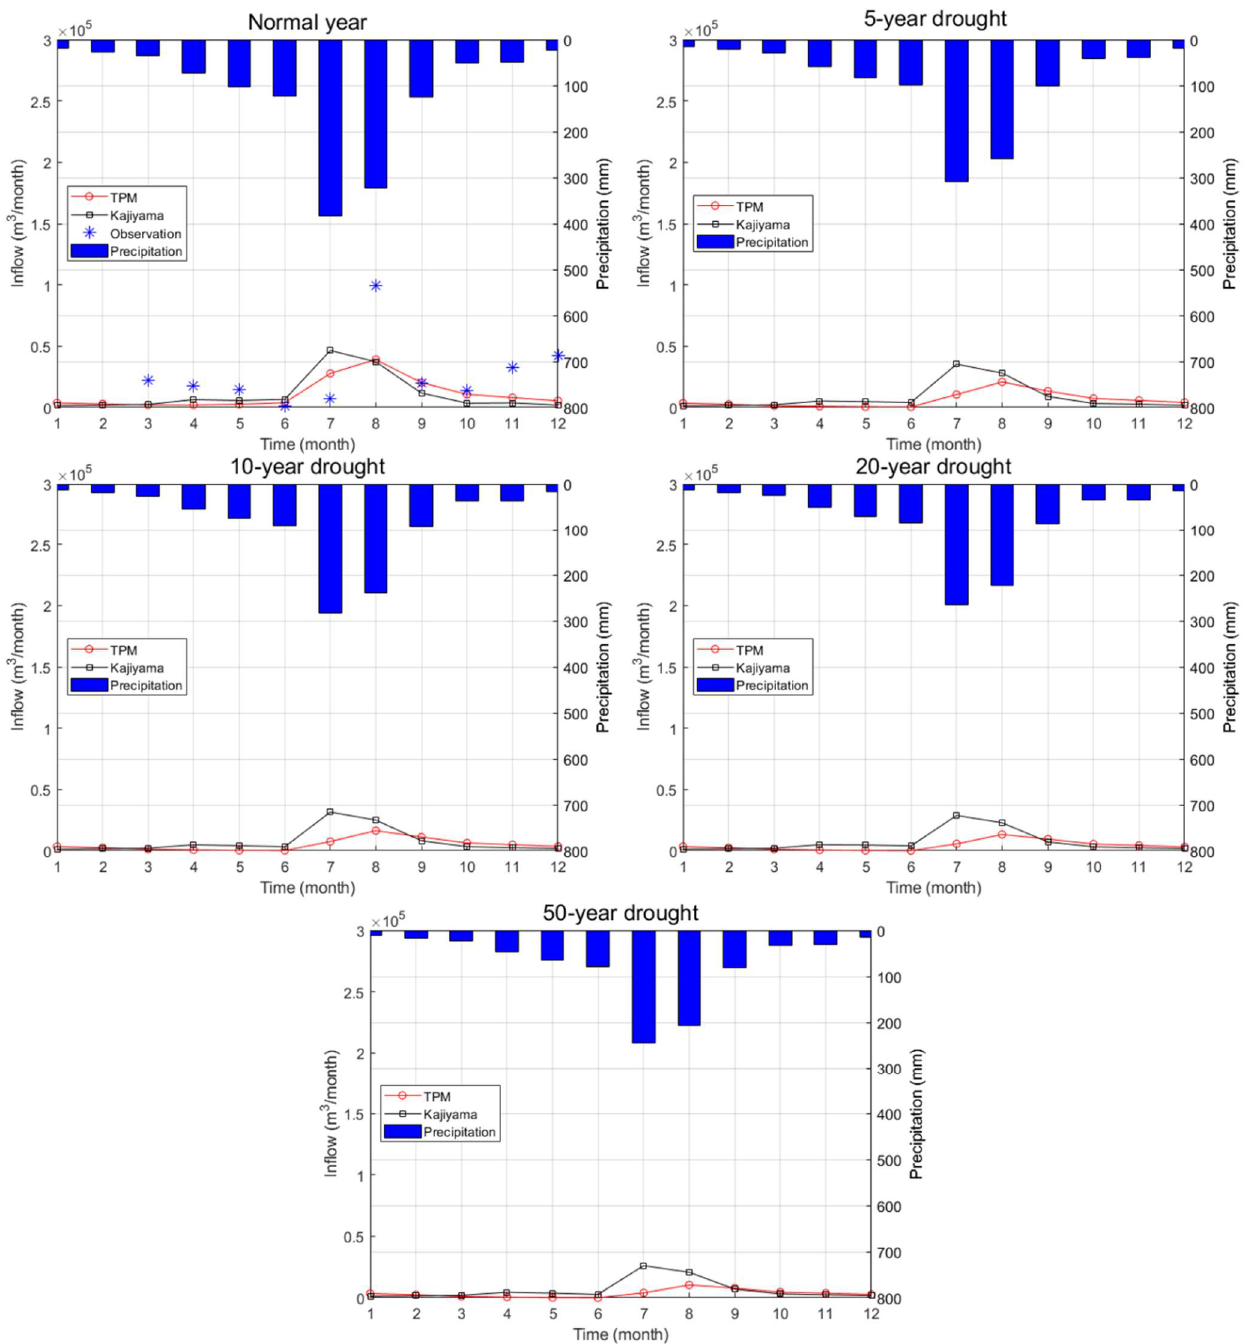
Figure 8. Precipitation and inflow to sand dam for various drought conditions (normal, 5-, 10-, 20-, and 50-year frequency). Data observed in a normal year are shown along with model estimates.